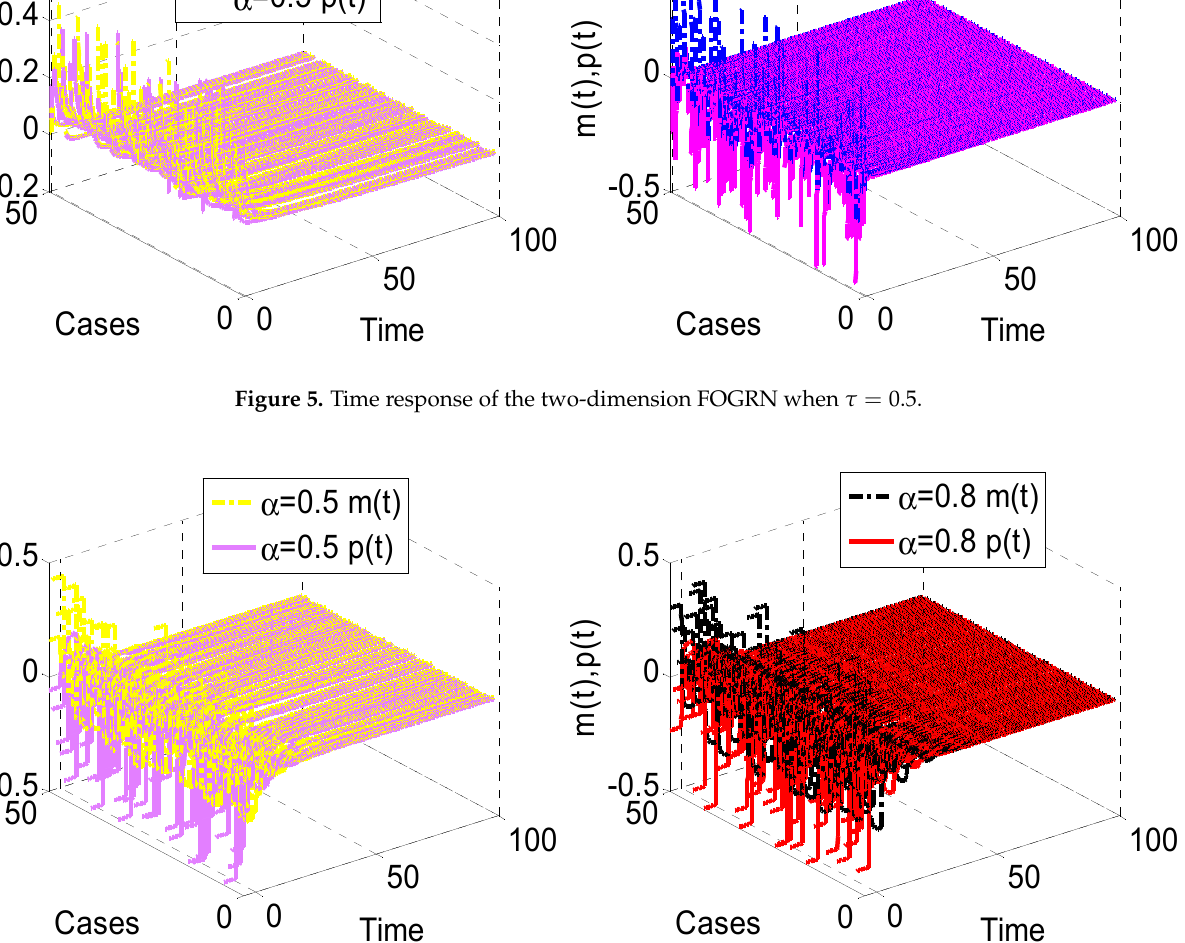
Figure 6. Time response of the two-dimension FOGRN when τ = 5.